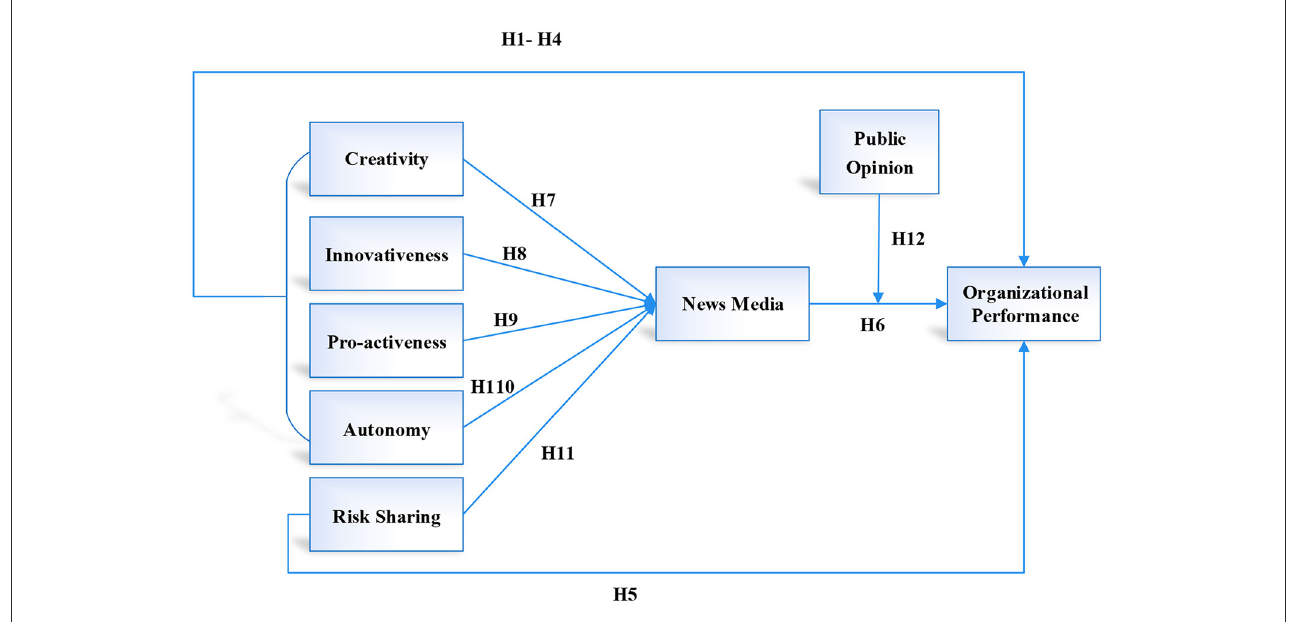
FIGURE1 Conceptual